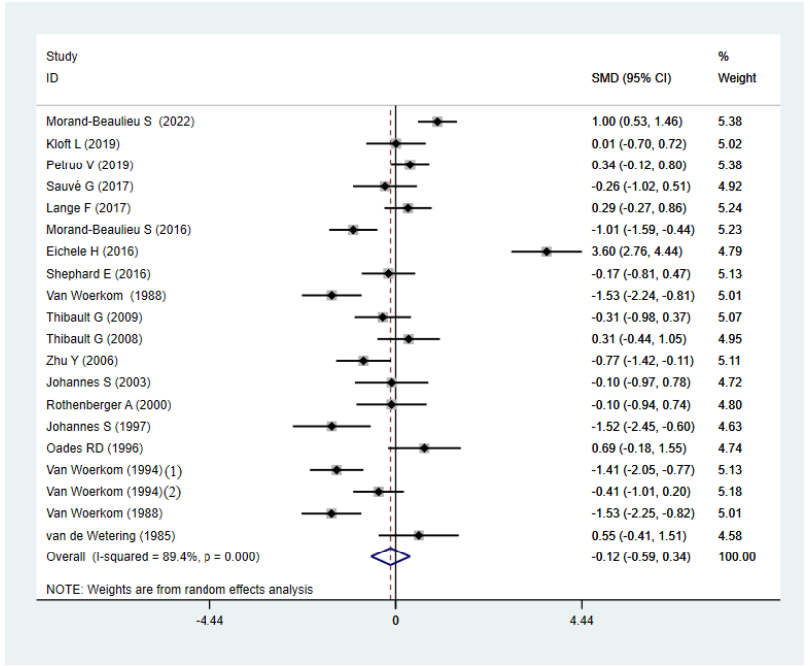
Figure 2. Forest map of P3b amplitude of TD patients and HCs. SMD: Standard Mean Difference; CI: confidence interval.